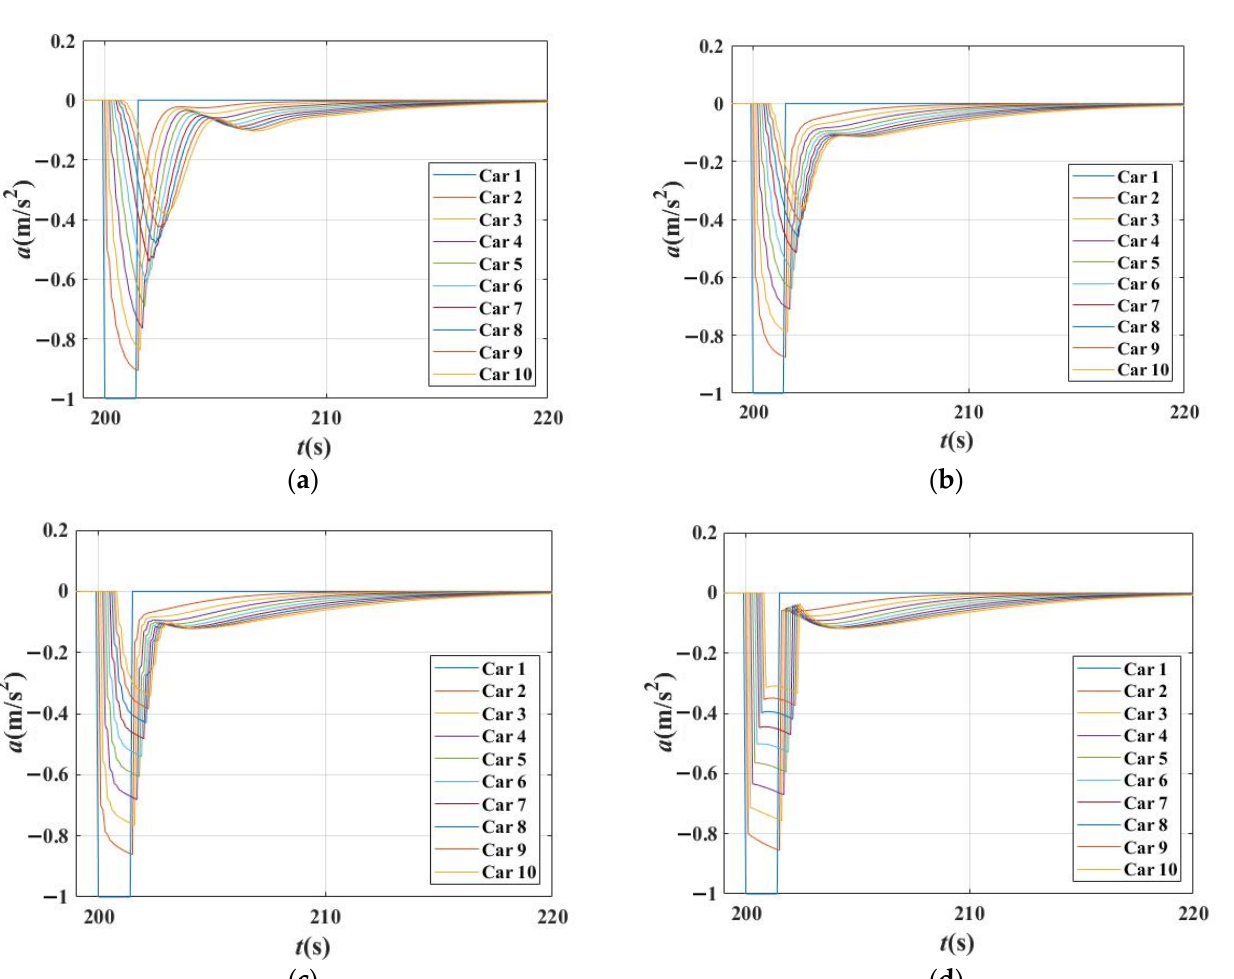
Figure 10. Acceleration changes for each vehicle in the platoon in different scenarios when β 1 + β 2 = 0.8 and time gap T = 1.5 s in IDM. ( a ) Acceleration changes for each vehicle in the platoon when β 1 = 0.5, β 2 = 0.3; ( b ) Acceleration changes for each vehicle in the platoon when β 1 = 0.6, β 2 = 0.2; ( c ) Acceleration changes for each vehicle in the platoon when β 1 = 0.7, β 2 = 0.1; ( d ) Acceleration changes for each vehicle in the platoon when β 1 = 0.8, β 2 = 0.